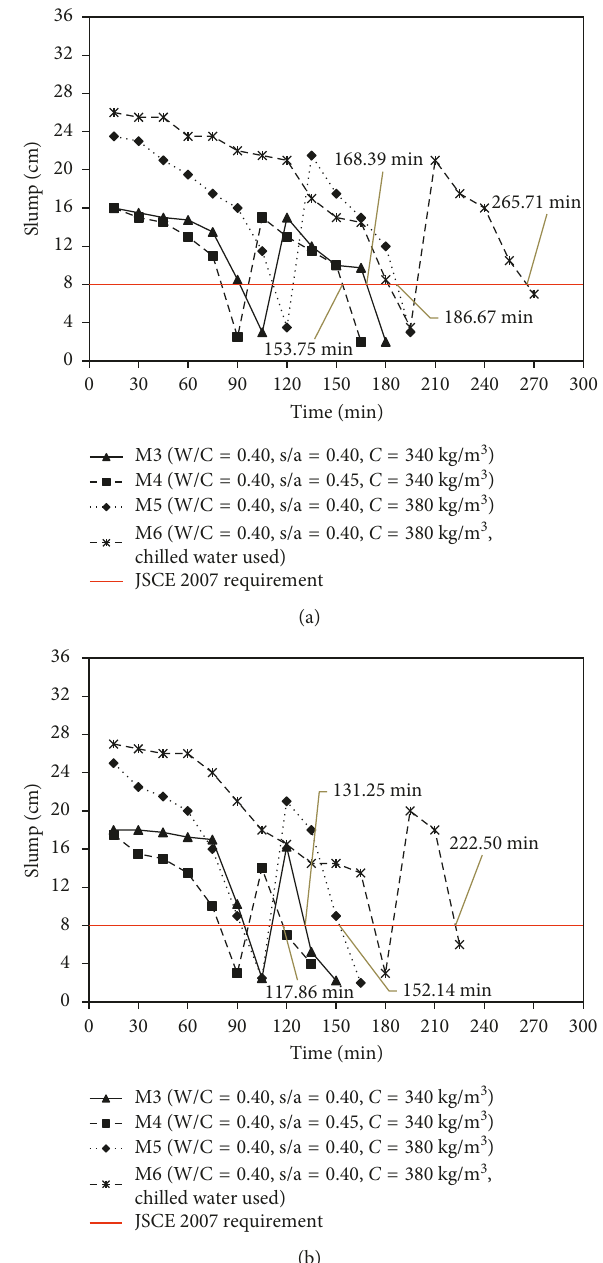
Figure 3: Slump test results of M3, M4, M5, and M6 mixtures: (a) sulfonated naphthalene polymer-based SP1 (maximum dosage of admixture in two stages) and (b) second-generation poly- carboxylic ether-based SP3 (maximum dosage of admixture in two